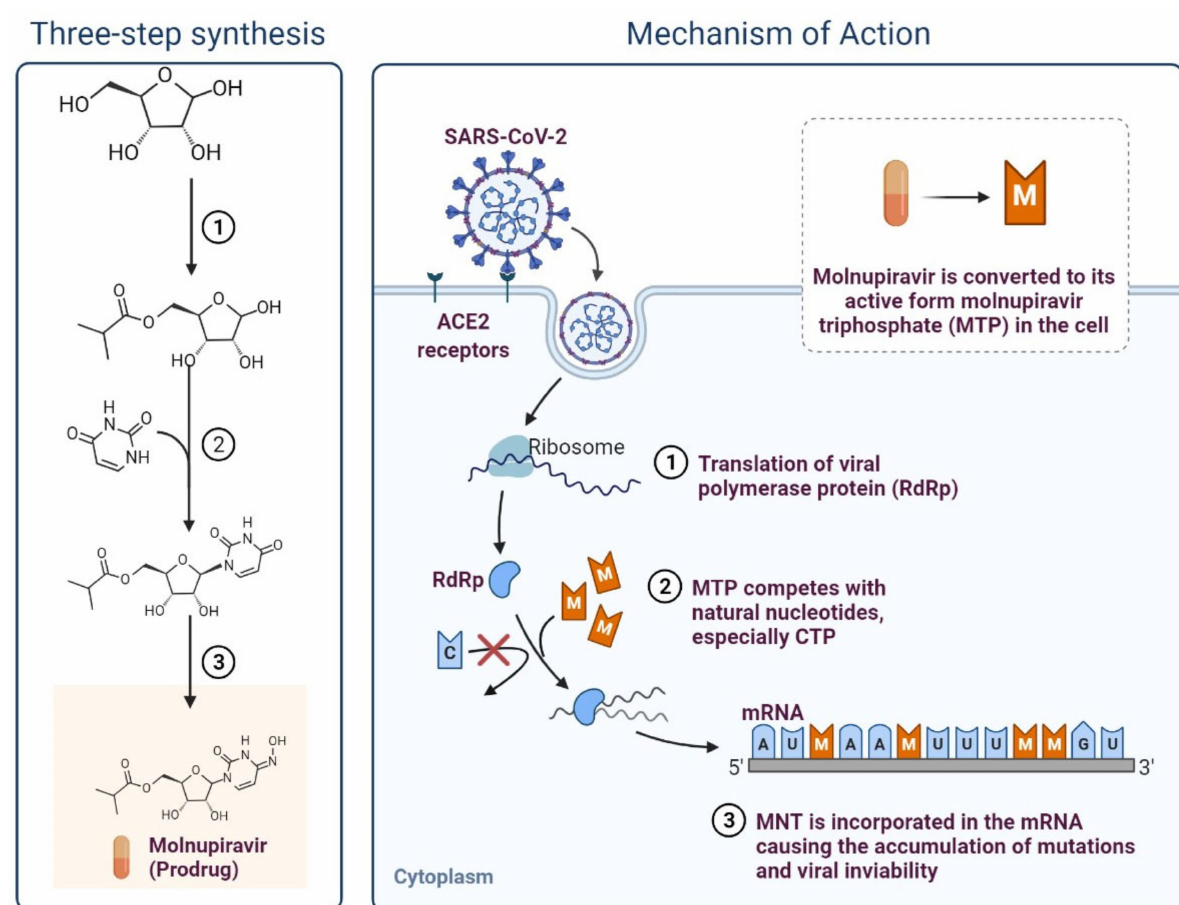
Figure 10. Molnupiravir; Potential repurposed drug candidate for